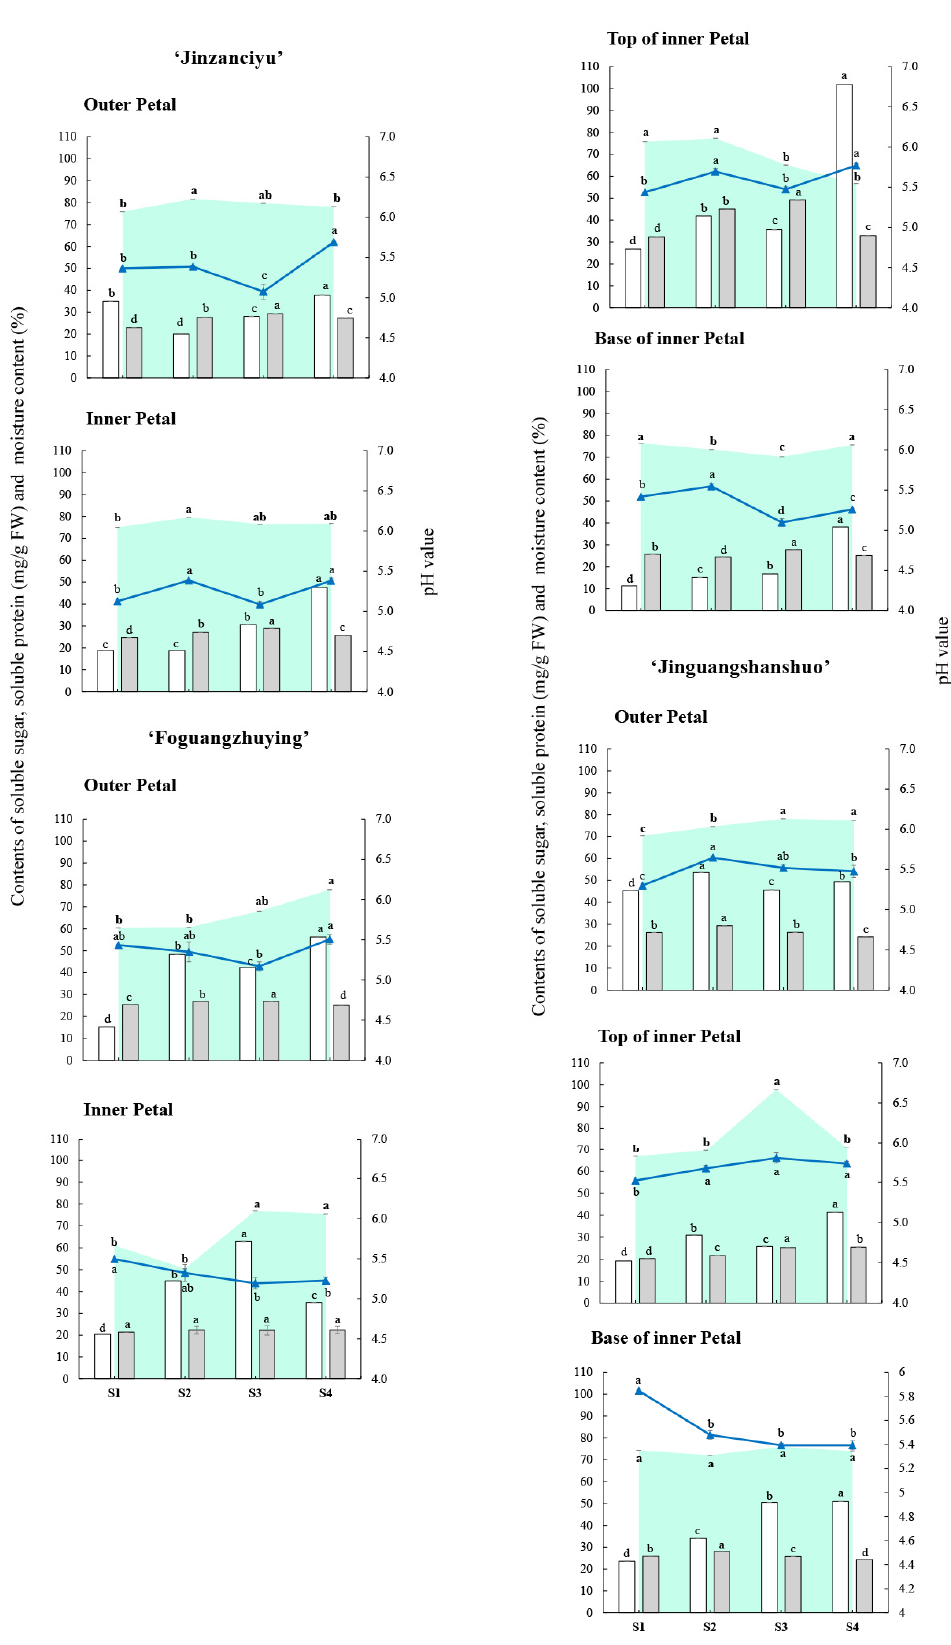
Figure 2. Changes in the related physiological indexes in different flowering stages of the herbaceous peony. Notes: The data sets of the same variety and the same petal position at different flowering stages were analyzed. Different lowercase letters indicate significant differences at p < 0.05